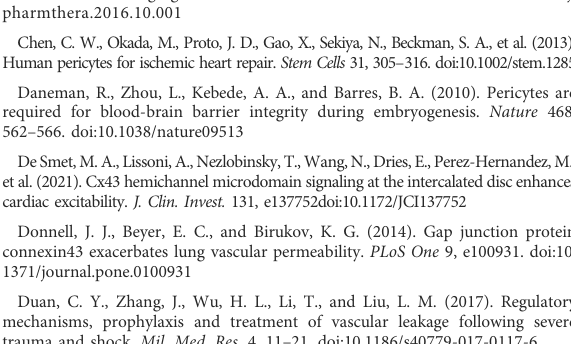
SUPPLEMENTARY FIGURE 1 The amount of PC in blood vessels and identi fi cation of PCs. (A) Identi fi cation of PCs by immuno fl uorescence (n = 3). (B) PCs were transfected with GFP-adenovirus (n = 3). (C) The protein expression of Cx43 in PCs determined by WB (n = 3). (D) The change of the amount of PC in vessels during hemorrhagic shock by immuno fl